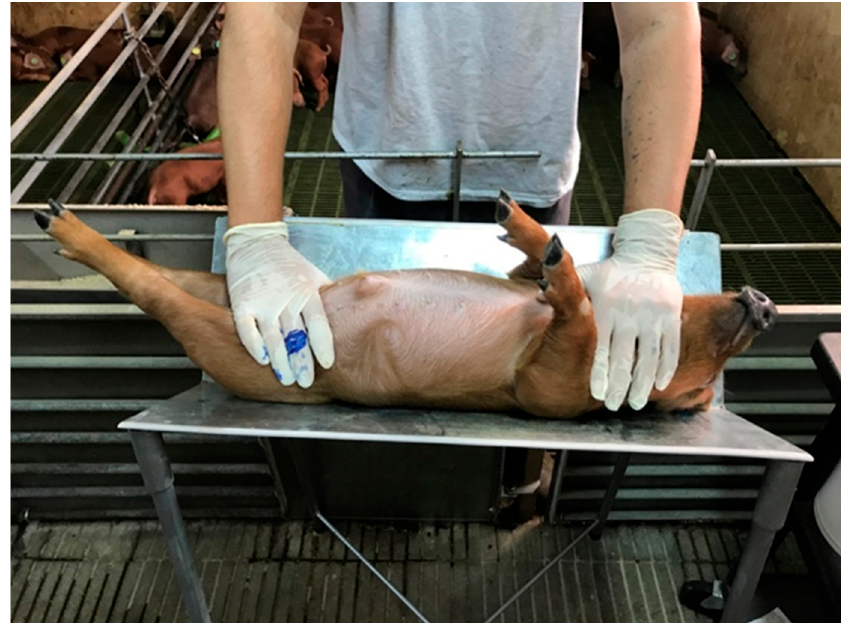
Figure 1. Piglet subjected to laid supine during backtest.